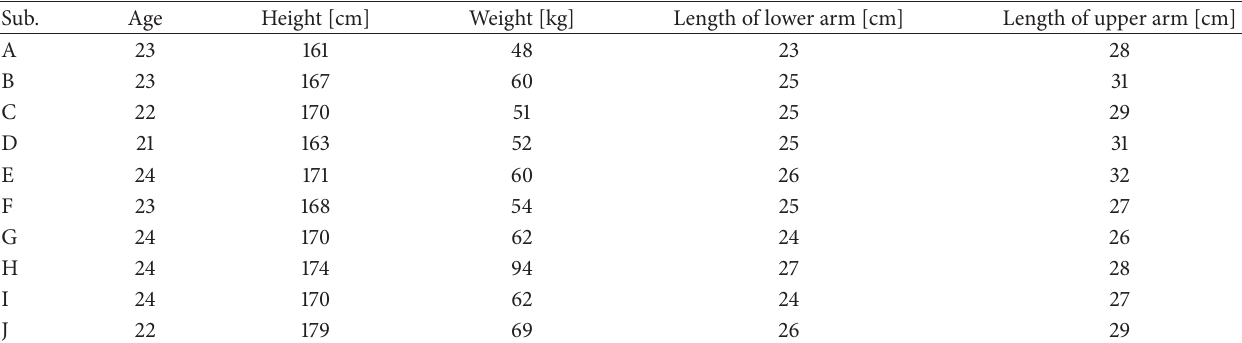
Table 2: Body dimension.